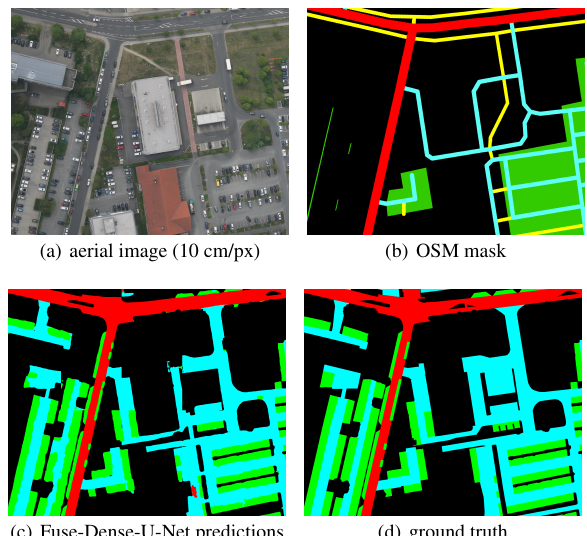
Figure 1. Illustration of the dataset and the results: (a-b) input data, (c) predictions of our best model, (d) manually annotated ground truth. Categories colors are: ∎∎∎∎∎∎∎∎∎∎∎∎∎∎∎∎∎ parking area, ∎∎∎∎∎∎∎∎∎∎∎∎∎∎∎∎∎ road, ∎∎∎∎∎∎∎∎∎∎∎∎∎∎∎∎∎ access way and ∎∎∎∎∎∎∎∎∎∎∎∎∎∎∎∎∎ pedestrian/bike